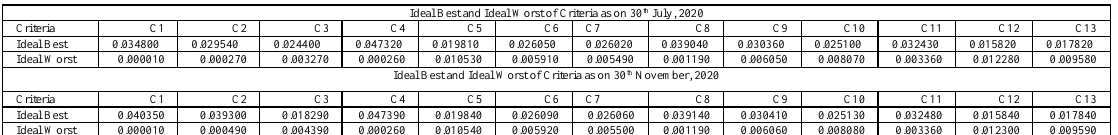
Table 4 . Ideal Best and Ideal Worst of